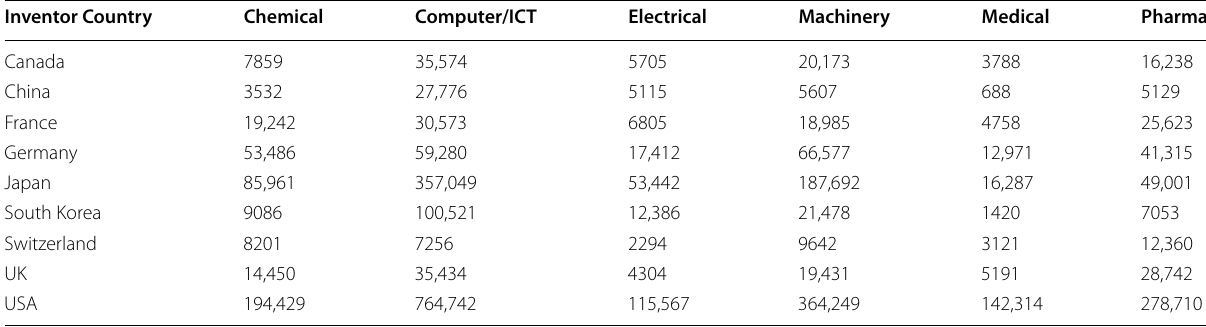
Table 5 Number of patent UPC-IPC code combinations per country and industry